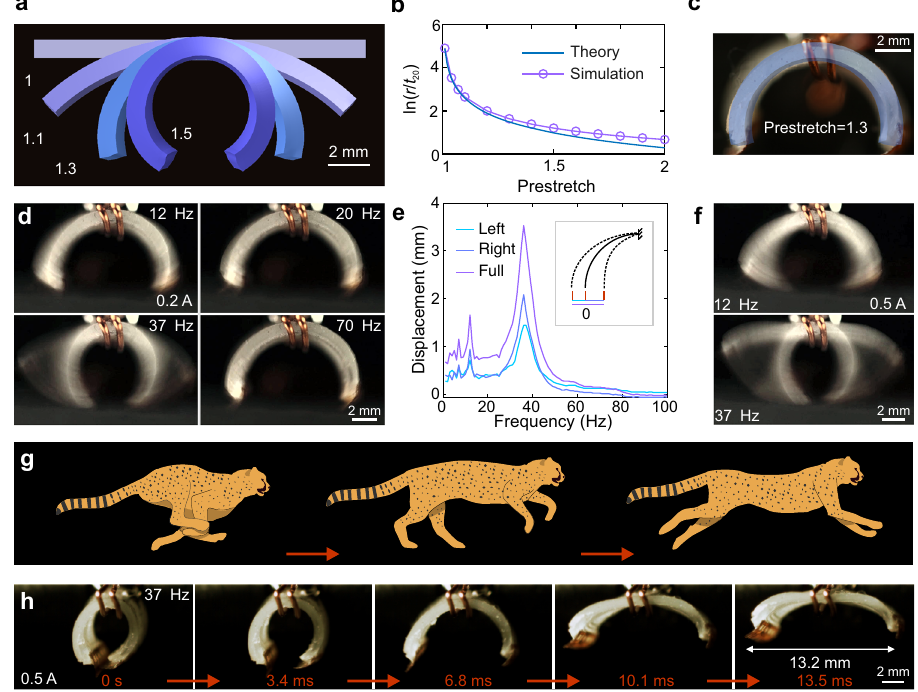
Fig. 2 | Design and characterization ofsmall-scale SEMRs. a Simulated shape of the bilayer fi lm with different prestretches: 1.0, 1.1, 1.3, and 1.5. b Simulated and calculated radius of the bilayer fi lm as a function of the applied prestretch. c Superimposed pictures of the experimental and simulated SEMR shapes (side view)withaprestretchof1.3. d SnapshotsoftheSEMRvibrationsfor0.2Asquare- wave current with different frequencies (Supplementary Movie 2). The 37Hz and 12Hz frames correspond to the main and the second-largest spectral maxima, which can be seen in e . e Horizontal displacement of the left foot of the robot subjected to a 0.2A square-wave current at different frequencies (Supplementary Movie2).Therobotismountedonthetopofamagnetandclamped inthemiddle